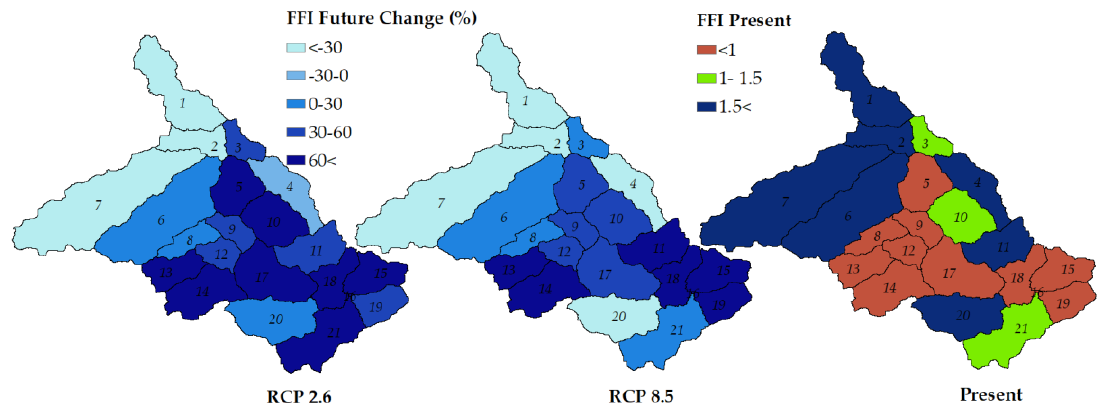
Figure 11. Flood Frequency Index (FFI) for the present period in each subbasin and percent change of FFI in each subbasin in the near future.